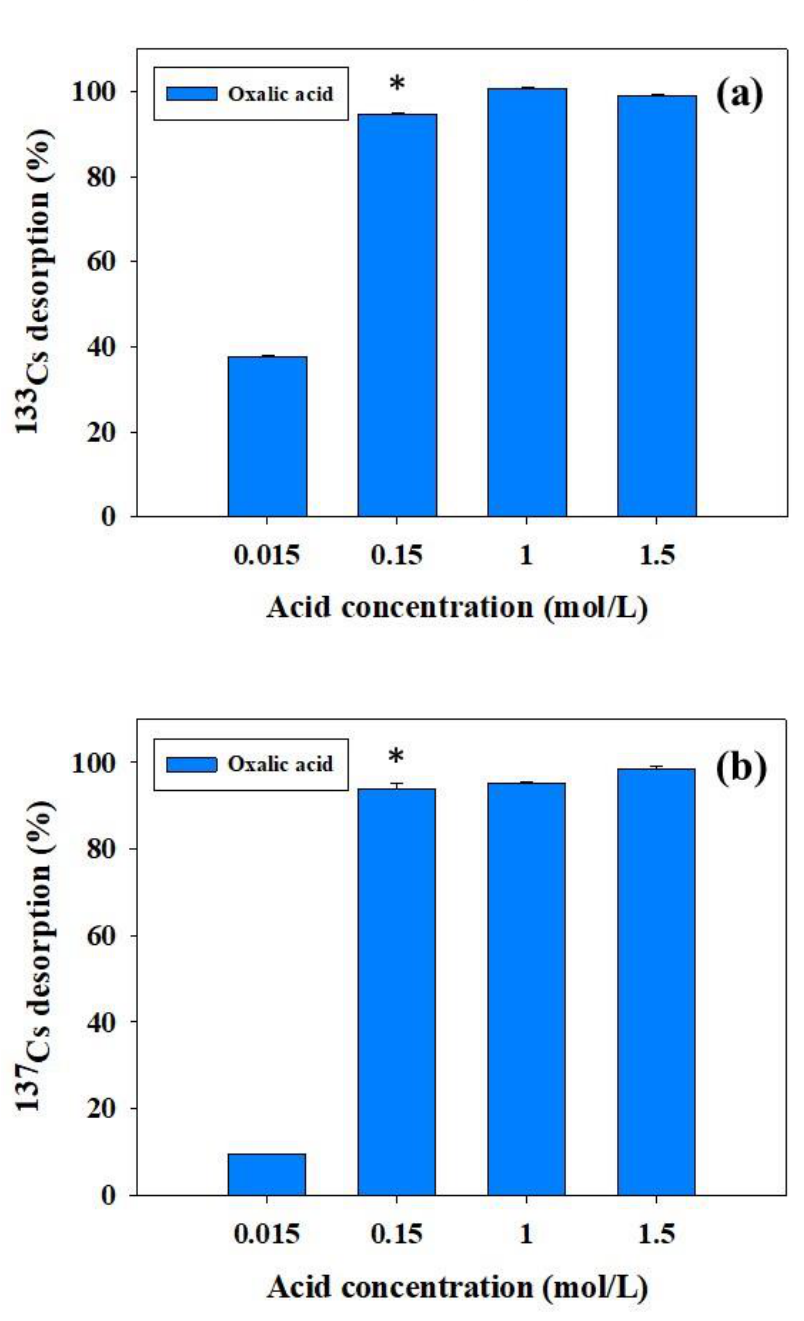
Figure 2. Removal e ffi ciency of ( a ) non-radioactive ( 133 Cs) and ( b ) radioactive ( 137 Cs) cesium from HBT at various concentrations (0.015–1.5 M) of oxalic acid at 70 ◦ C for 2 d. (n = 3, mean ± standard error of mean). * Optimal dosage concentration of oxalic